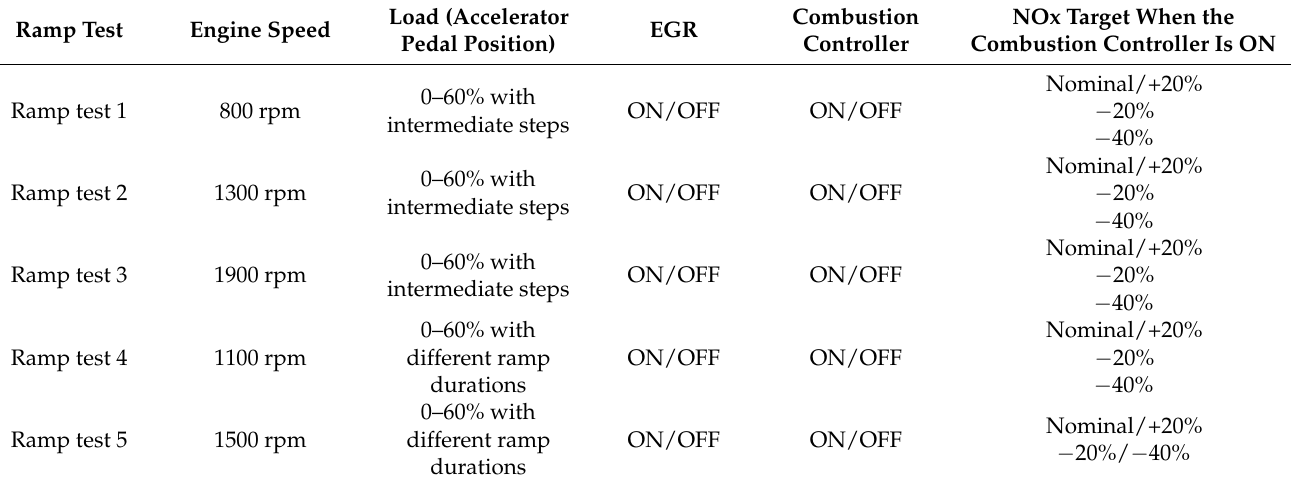
Table 2. Summary of the performed tests.